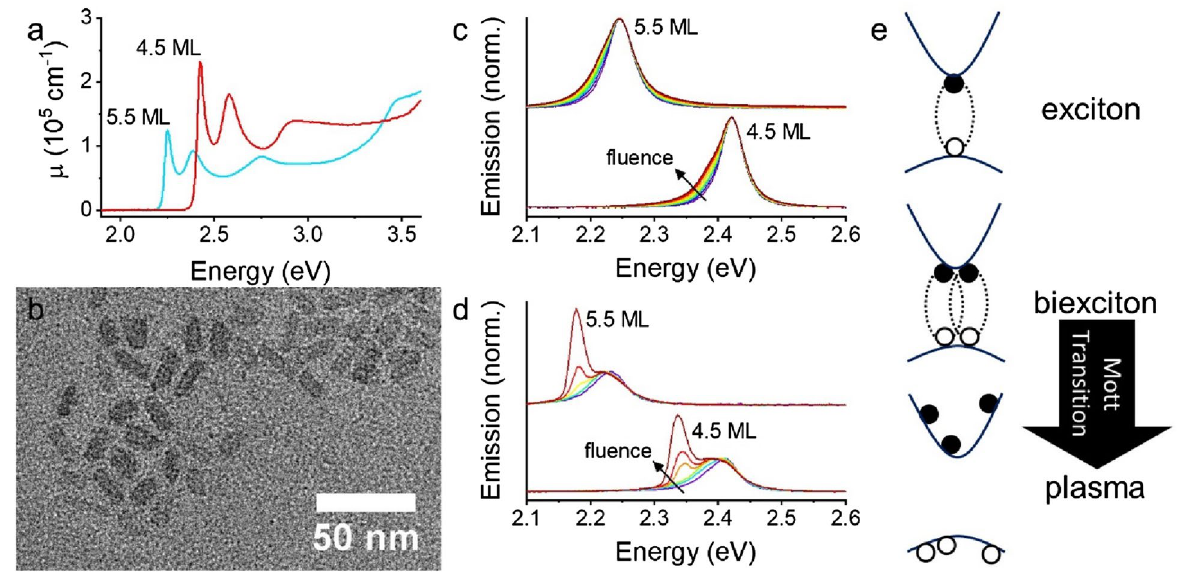
Figure 1. ( a ) Linear absorption (cm −1 ) of 4.5 and 5.5 monolayer (ML) CdSe colloidal quantum wells (CQWs) based upon literature data. ( b ) Typical TEM image of 4.5 ML CdSe CQW sample. ( c ) Normalized, fluence- dependent emission of CQW solutions. ( d ) Normalized, fluence-dependent emission of CQW films illuminated with a 400 μm diameter spot. Normalization is to the excitonic emission peak. ( e ) Cartoon of single exciton, biexciton, and transition to unbound carrier